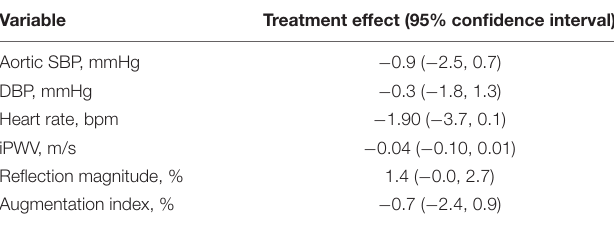
TABLE 3 | Treatment effects and 95% confidence intervals of 24 h ambulatory measurements after beetroot juice ingestion compared to